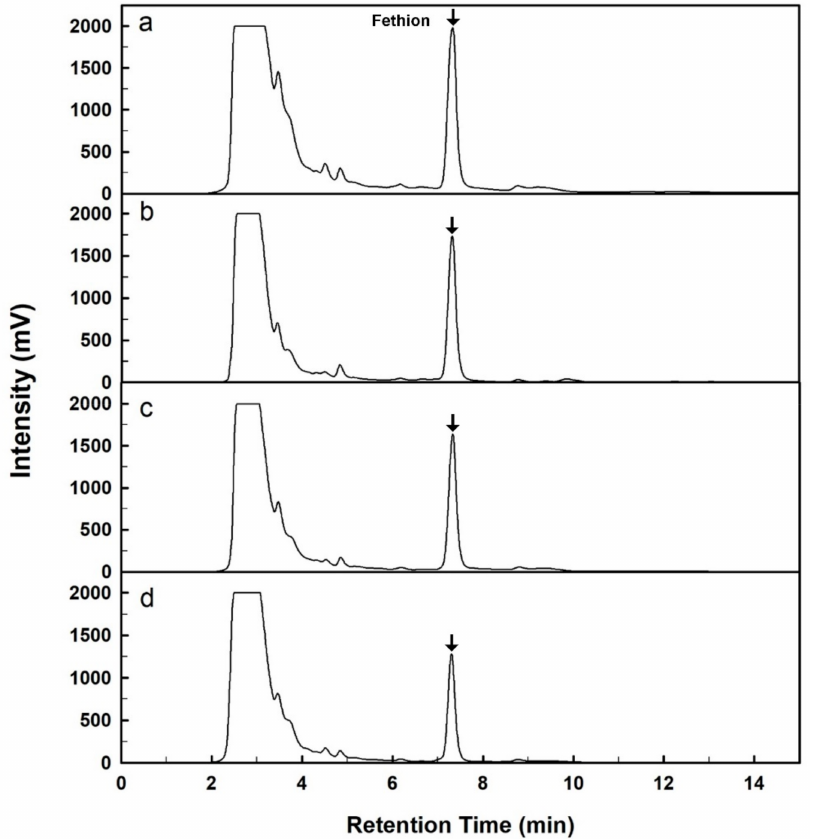
Figure 6. HPLC chromatographs of the intentionally fenthion-contaminated